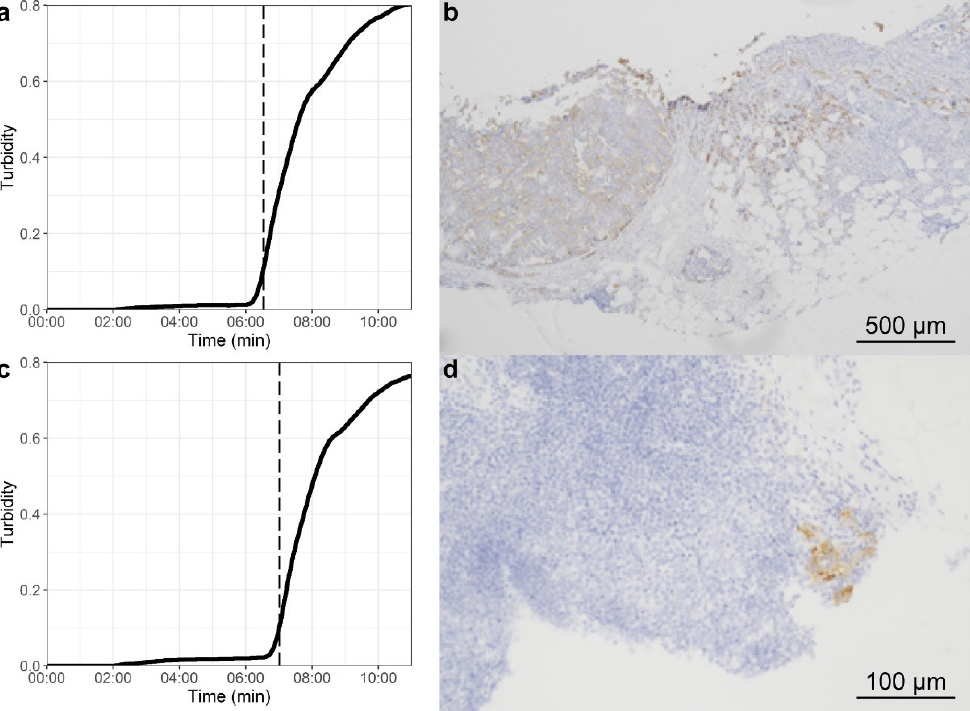
Figure 1. Detection of CK19 expression in one LN with macrometastasis ( a , b ) and in one LN with micrometastasis ( c , d ), each from the same PCa patient. ( a , c ) Amplification curves from OSNA analysis, which determines CK19 mRNA copy numbers (micrometastasis: 250–4999 c/ µ L, macrometastasis: ≥ 5000 c/ µ L) as a surrogate for metastasis. Vertical dotted lines plotted in the amplification curves express the rise time (time needed for precipitation of magnesium pyrophosphate to reach a turbidity of 0.1 OD at 465 nm). Rise time is shorter in macro- (06:32 min, ( a )) than in micrometastasis (07:01 min, ( c )). ( b , d ) Images show CK19 IHC stainings (total magnification for macrometastasis ( b ) is 400 × and for micrometastasis ( d ) 2000×).